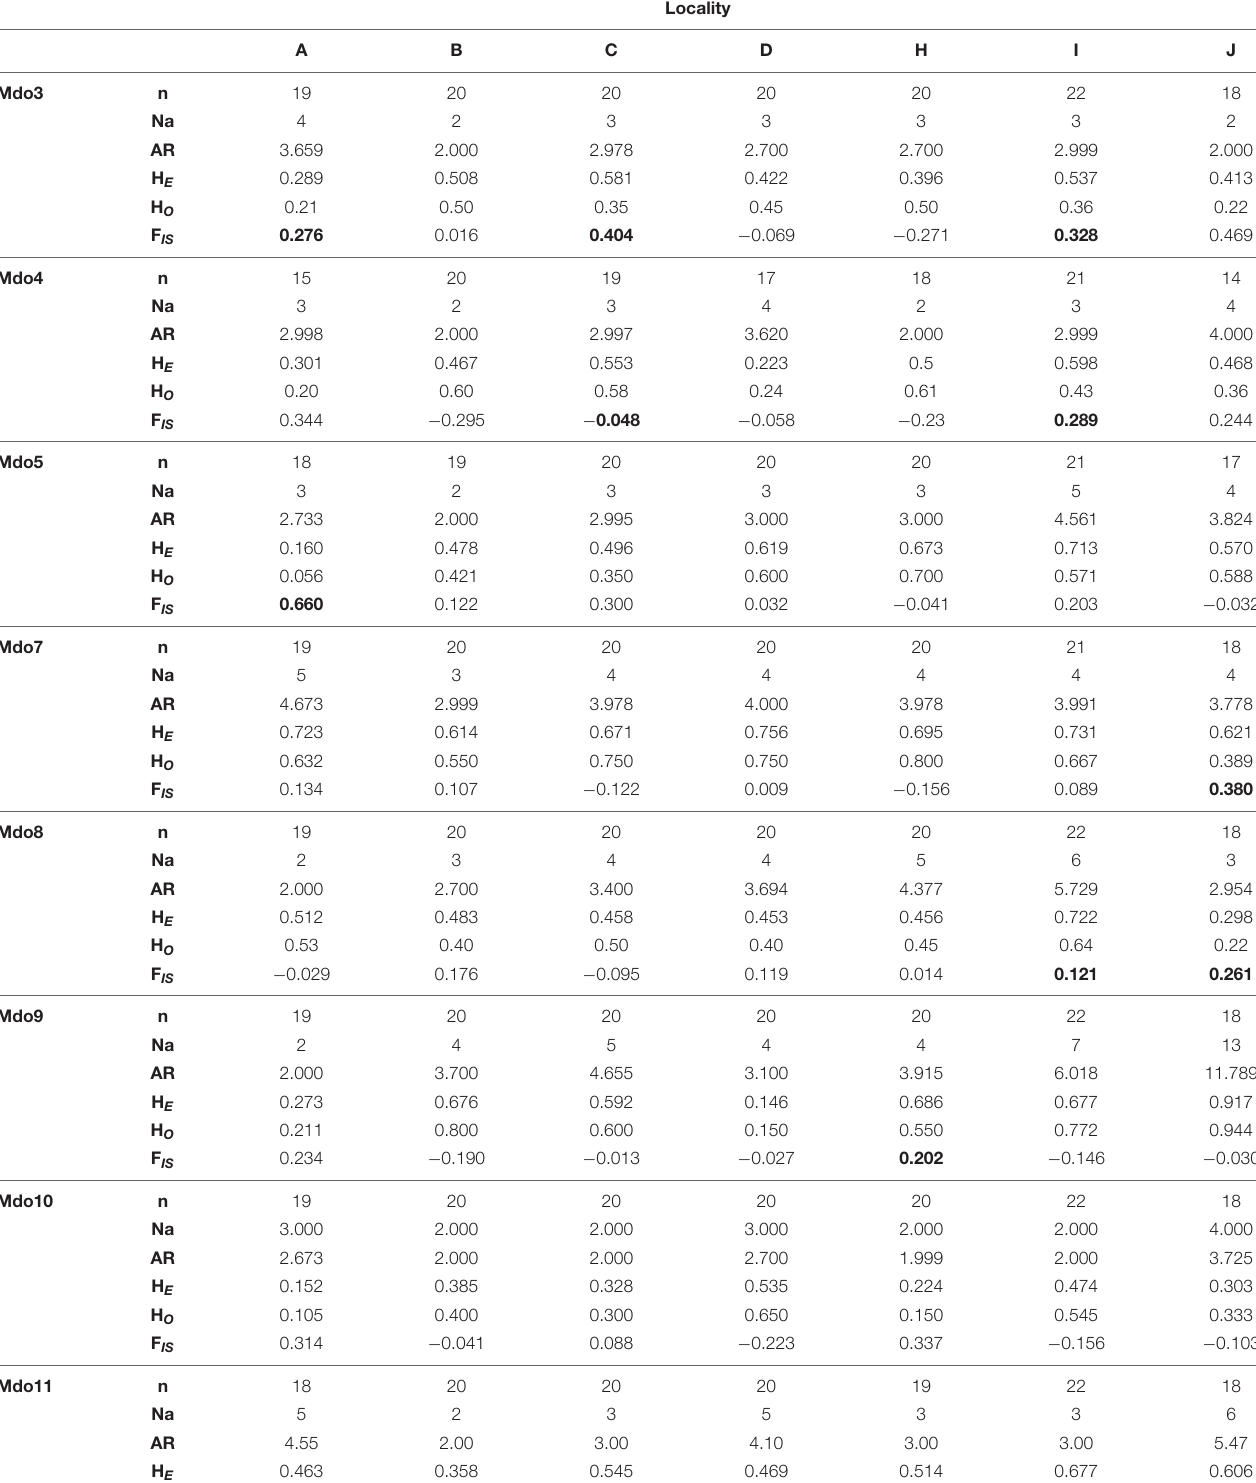
TABLE 2 | Genetic diversity measures ( n = number of genotyped individuals; Na = number of alleles; AR = allelic richness for a minimum of 15 individuals; H E = expected heterozygosity, H O = observed heterozygosity; F IS = inbreeding coefficient) for nine microsatellite loci amplified for each of the seven localities.